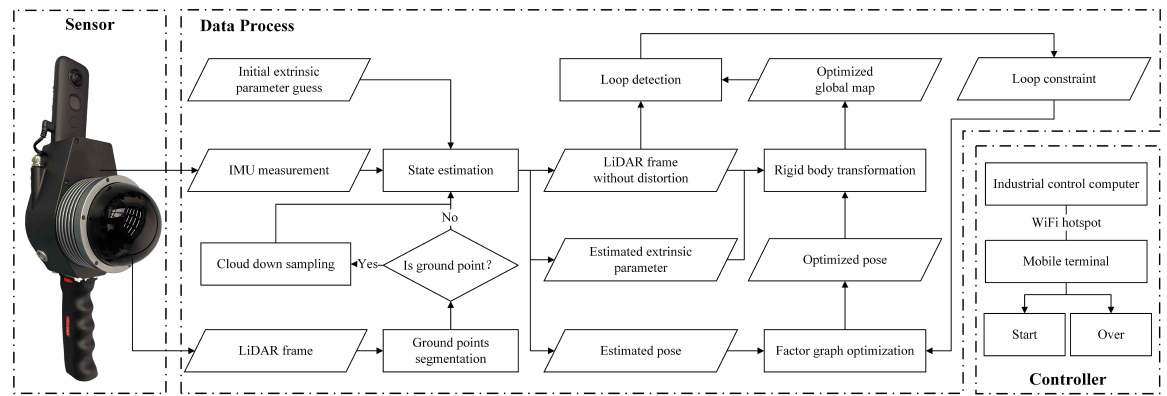
Figure 2. Workflow chart of the handheld hemispherical view laser scanning system SLAM method.